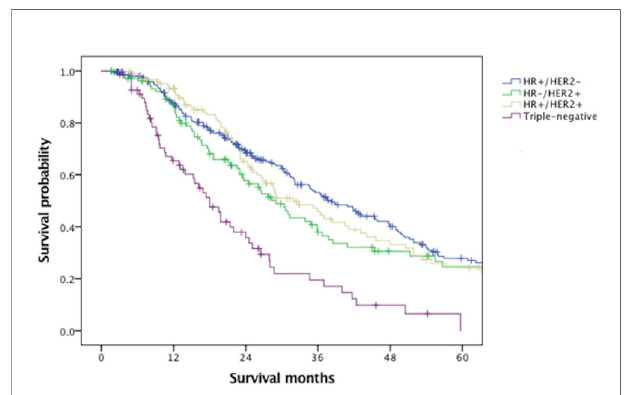
FIGURE 2 | Overall survival of patients with liver metastases strati fi ed by breast cancer subtype. HR, hormone receptor; HER2, human epidermal growth factor